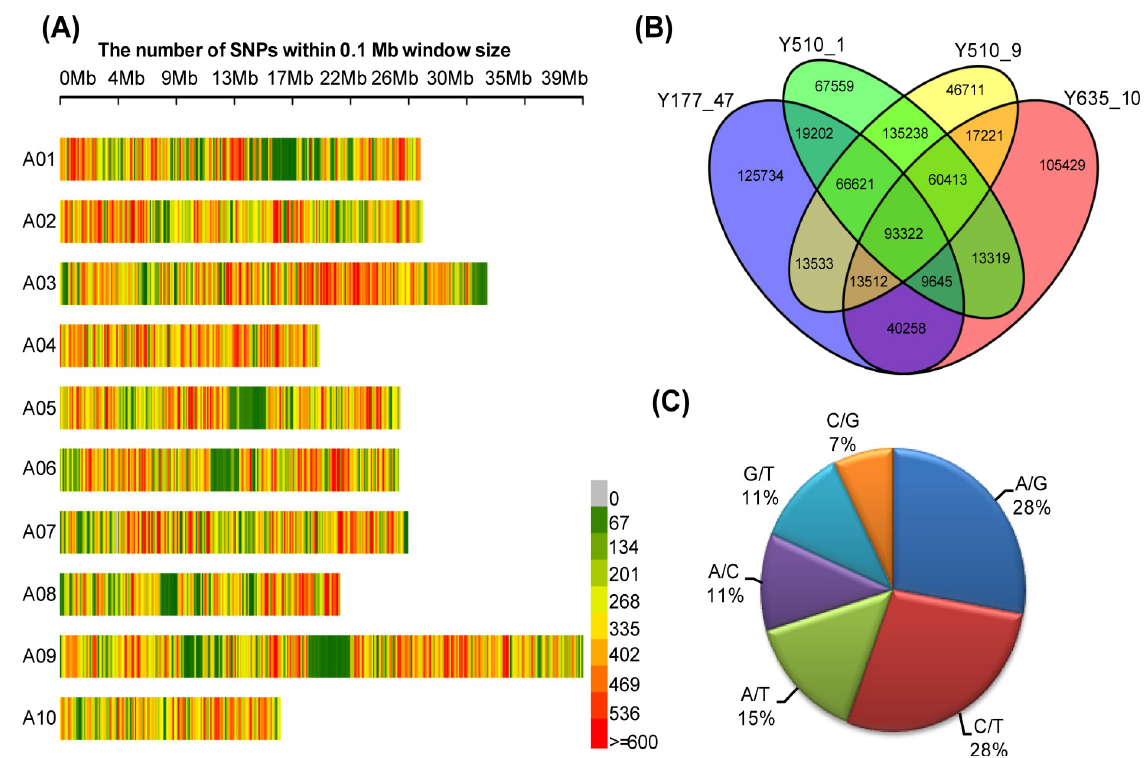
Fig 1. Number and type of SNPs identified in Chinese cabbage. (A) Distribution of SNPs in the pseudo-chromosomes of Chinese cabbage. (B) Venn diagram of SNPs among four Chinese cabbage DH lines. (C) Summary of SNP types identified in this study.